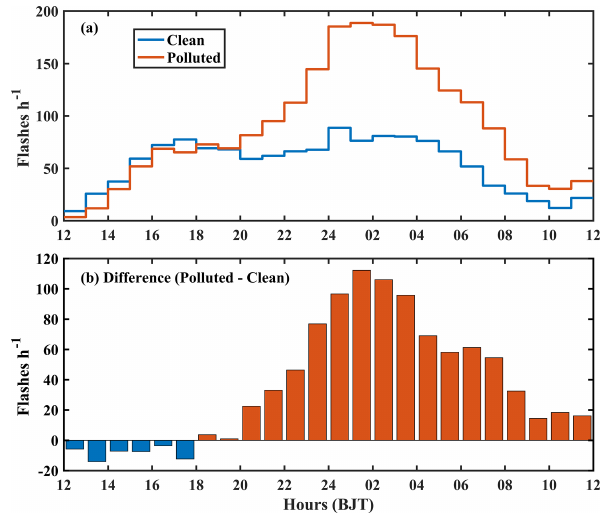
Figure 5. (a) The diurnal variations in lightning flashes (unit: flashesh − 1 ) under clean and polluted subsets over the study region during the summer (June, July, and August) season of 2010–2018. (b) The histogram of the difference in CG lightning flashes between polluted and clean